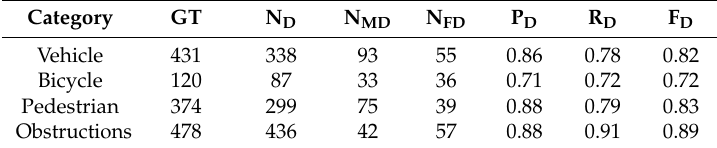
Table 4. Experimental evaluation of the obstacle detection module using sensors networks.